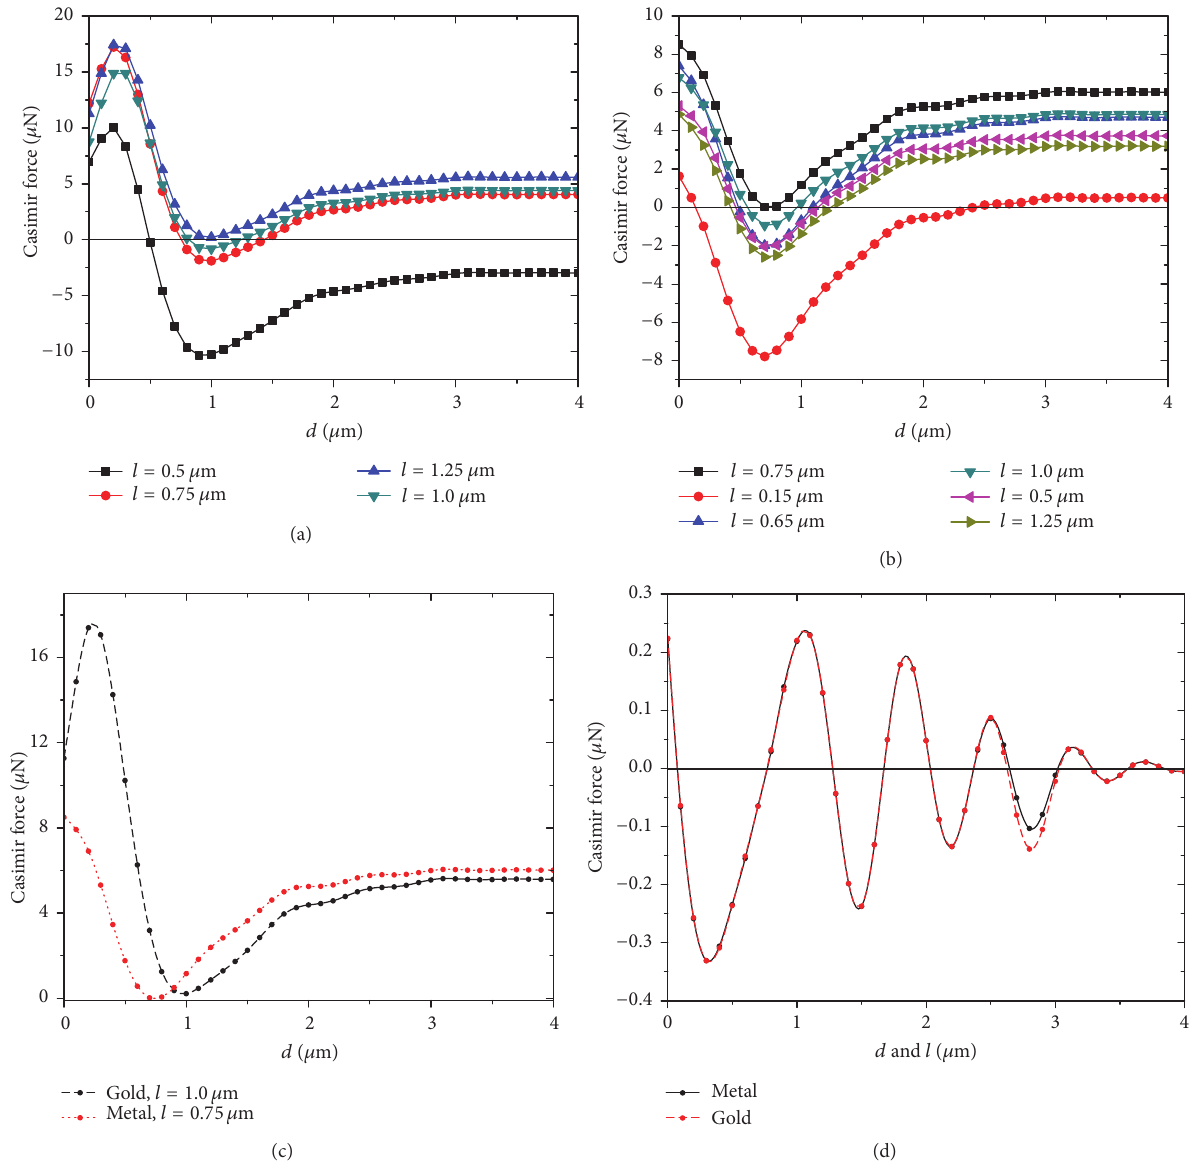
Figure 6: The Casimir force in plate-ellipsoid-plate configuration: (a) the material is gold. The black line shows that fixing the ellipsoid and the top plate at 𝑙 = 0.5 𝜇 m, the force becomes repulsive with the increase of 𝑑 . But the blue line indicates that as 𝑙 = 1.0 𝜇 m, the force is attractive. The red line and green line suggest that the force is almost attractive; (b) the material is perfect metal, and as 𝑙 = 0.75 𝜇 m the force is attractive; (c) shows the two different materials at two different points where the repulsive force becomes attractive; (d) as we fixed the ellipsoid and varied 𝑑 and 𝑙 simultaneously, the Casimir force fluctuated between attraction and repulsion.